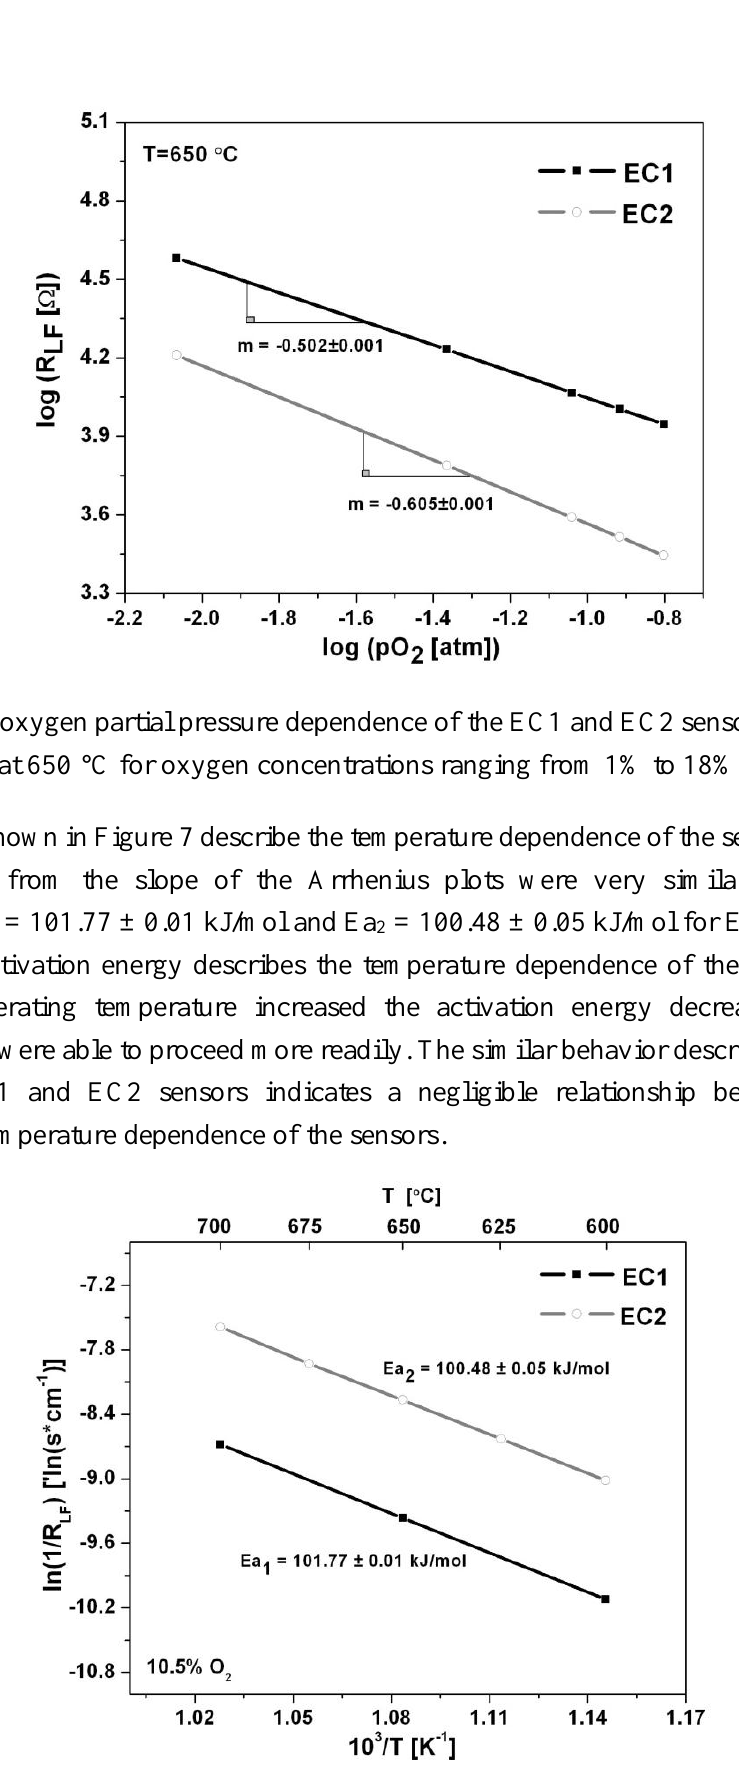
Figure 7. The temperature dependence is described by the Arrhenius plot for the EC1 and EC2 sensors along with corresponding activation